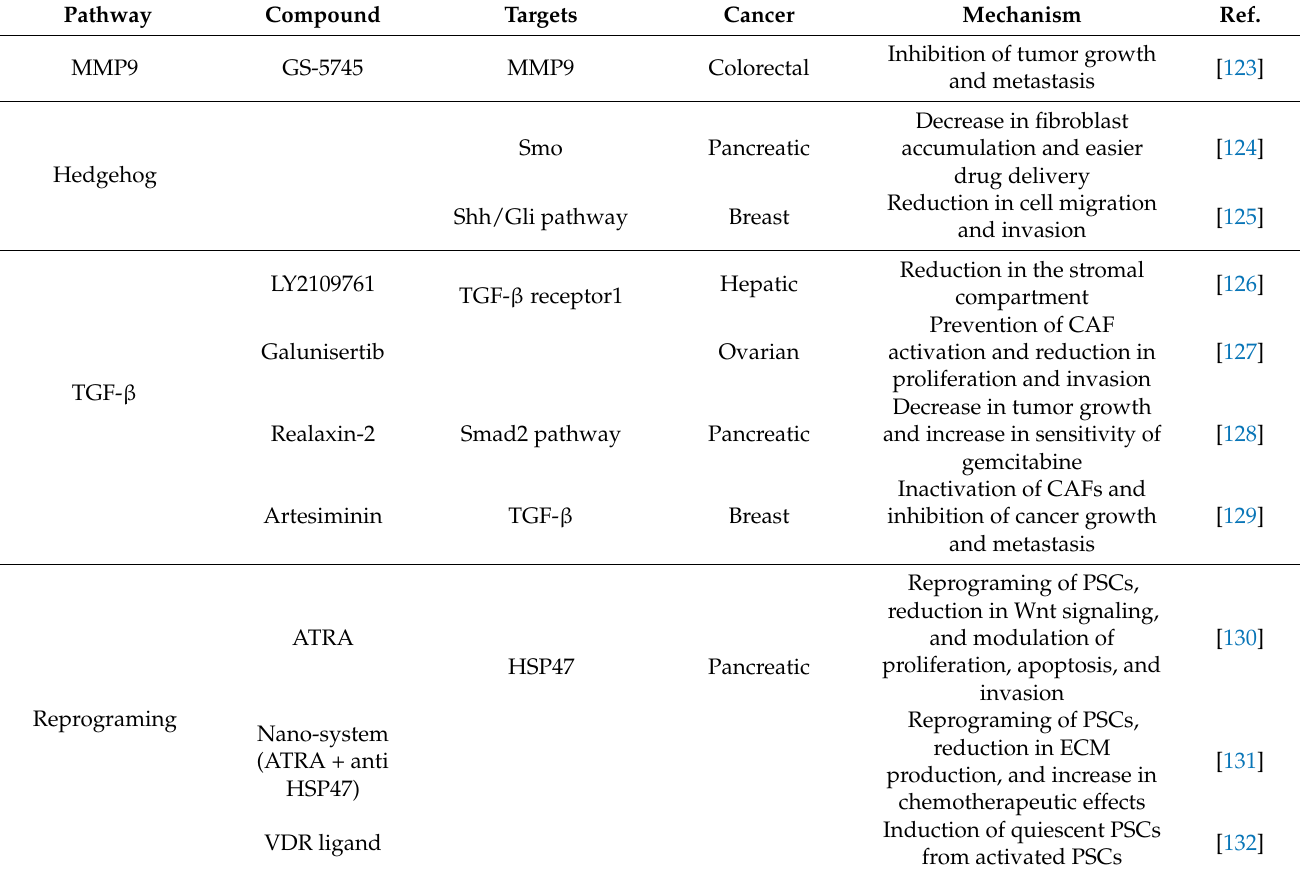
Table 1. Summary of CAF-targeted